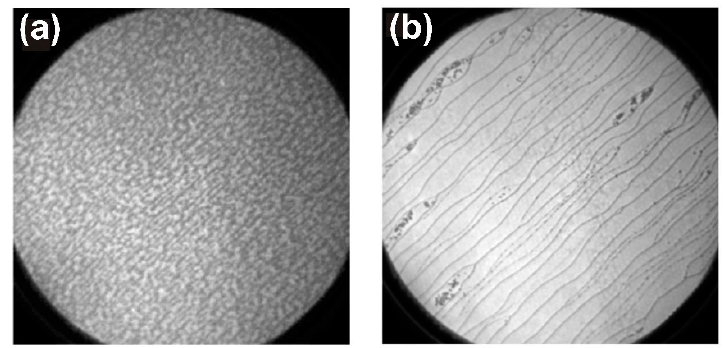
Figure 17. Graphene layers grown in ( a ) vacuum; ( b ) Ar [40].